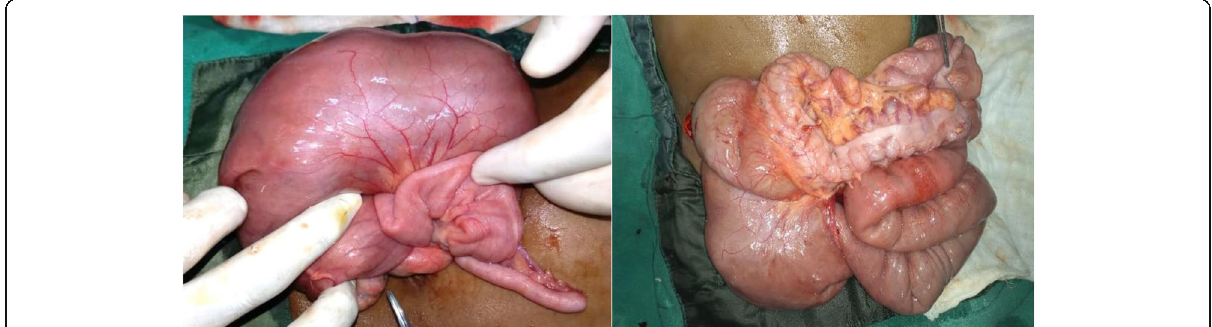
Fig. 3 a Dilated jejunum with normal appendix and caecum. b Dilated small bowel with normal appendix in left upper quadrant with presence of Ladd ’ s